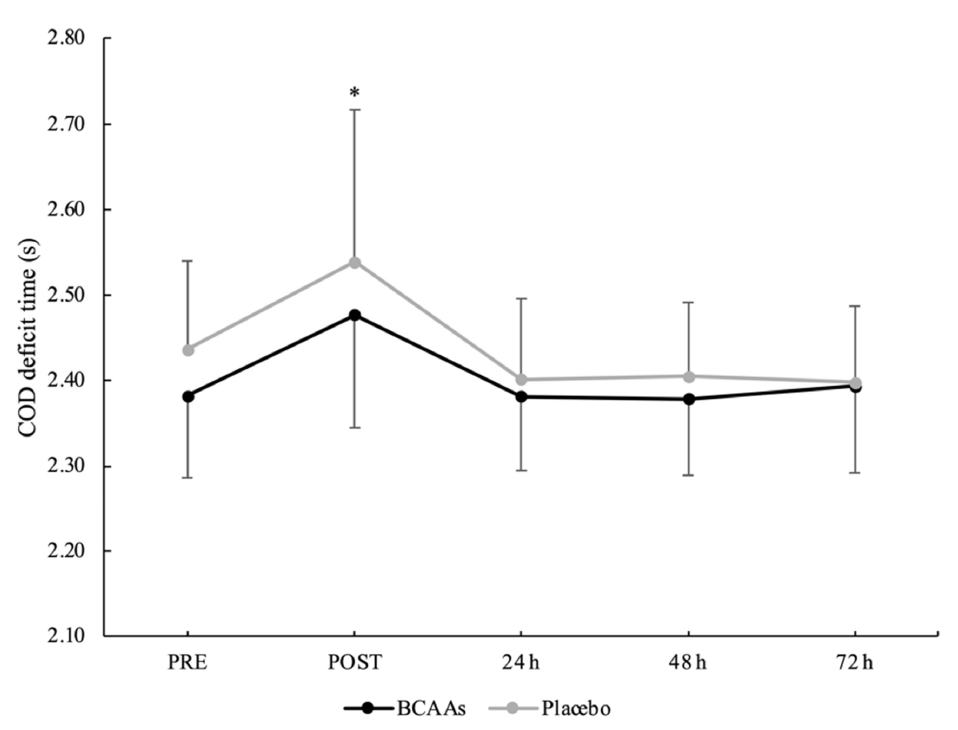
Figure 6. Total time for the 505 COD test during the time course of recovery. (*) Denotes differences ( p < 0.05) from all time ‐ point measurements.